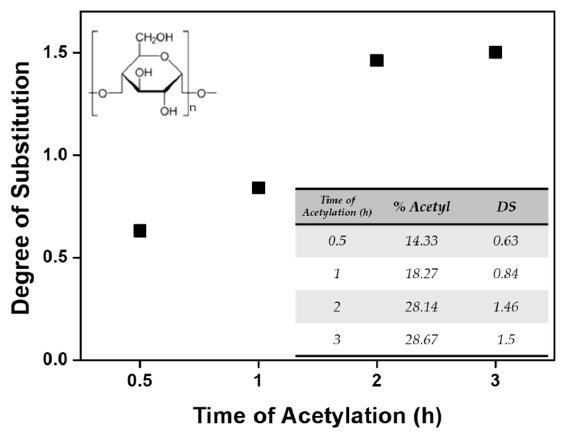
Figure 4. Acetyl content of acetylated kenaf fibers as a function of acetylation reaction time.